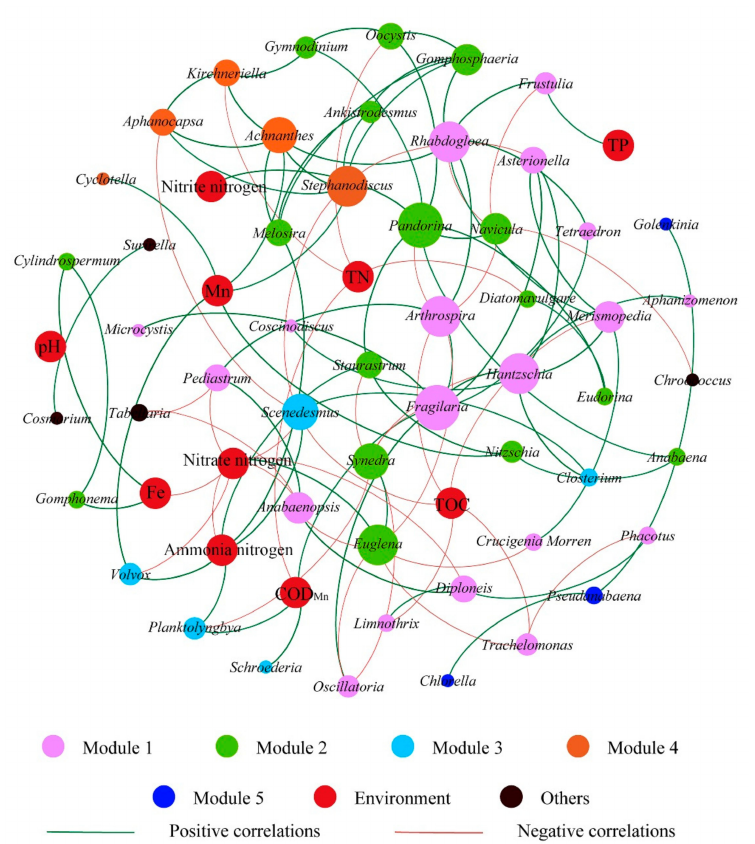
Figure 6. Network analysis revealing the modular associations between algal communities and environmental factors from 16 di ff erent urban lake samples. A connection stands for a strong (Spar CC | r | > 0.6) and significant ( p -value < 0.05) correlation. The nodes are colored according to modularity class. The size of each node represents value of betweenness